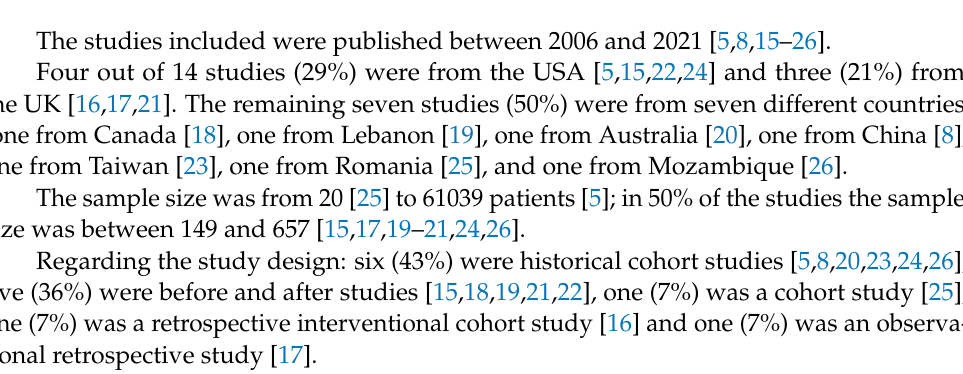
Figure 1. PRISMA flowchart of the included studies.